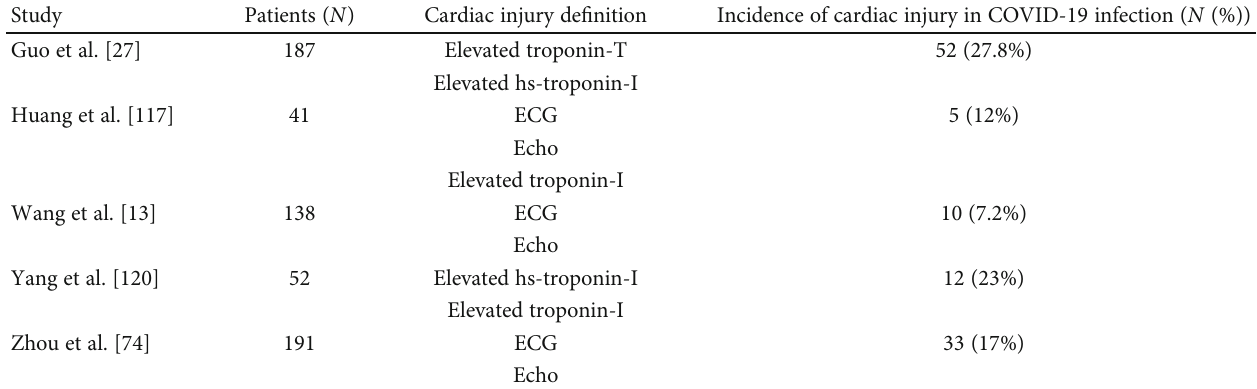
Table 2: De fi nition and incidence of cardiac injury from COVID-19